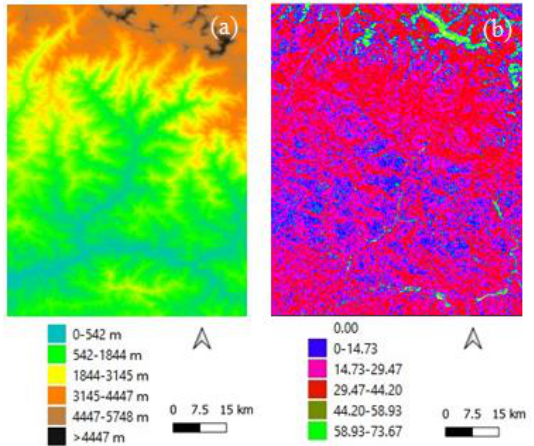
Figure 2. (a) Digital Elevation Model and (b) and slope of the study